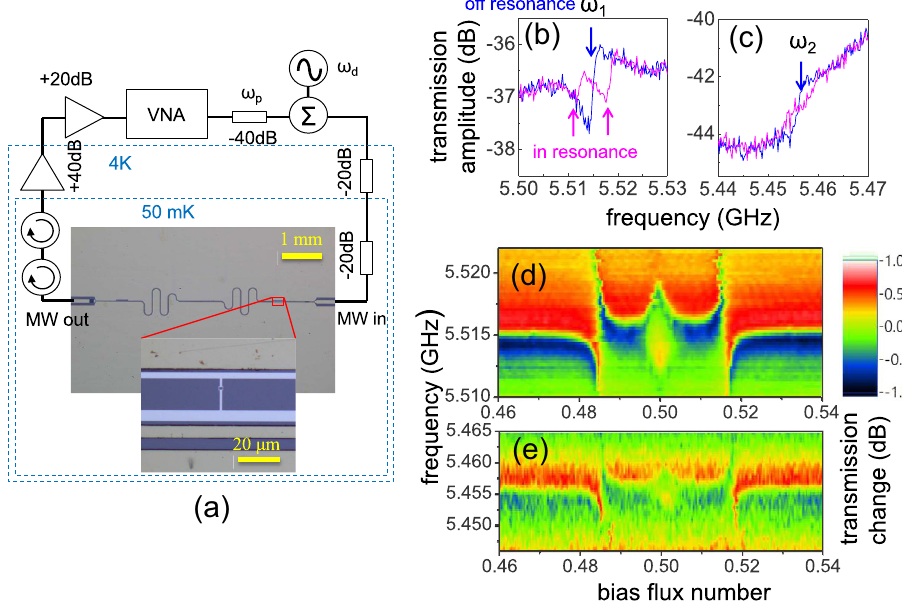
Figure 2. ( a ) The schematic of the 2-tone measurement. The transmon-like atom is placed in the slot of a transmission type resonator. ( b ) and ( c ) The microwave transmissions nearby the two resonances at 5.514 GHz ( b ) and 5.455 GHz ( c ). The curves are for the atom in resonance (red) and off-resonance (blue) with the 5.514 GHz mode. ( d ) and ( e ) The microwave transmission amplitude change as a function of bias flux number and frequency in the vicinity of 5.514 GHz ( d ) and the transmission amplitude change nearby 5.455 GHz ( e ). Both plots show the vacuum Rabi effect due to the coupling of the atom to the resonant